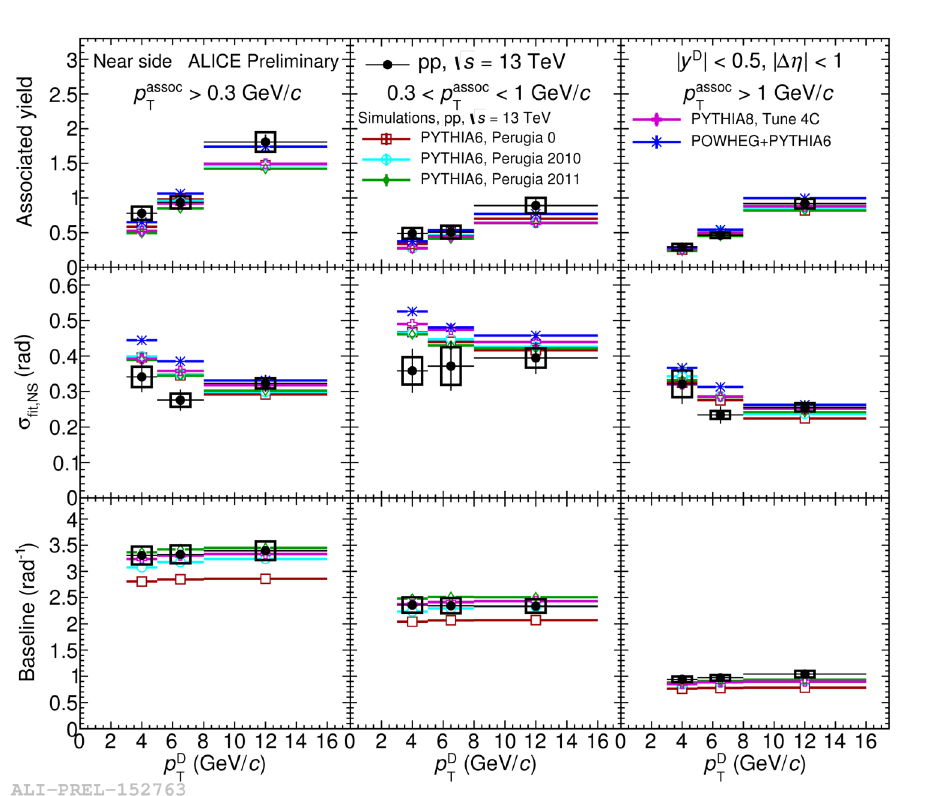
Figure 3. Comparison of near-side peak associated yield (top row), near-side peak width (middle row) and baseline (bottom row) values measured in pp collisions with the expectations from Monte Carlo simulations with di ff erent event